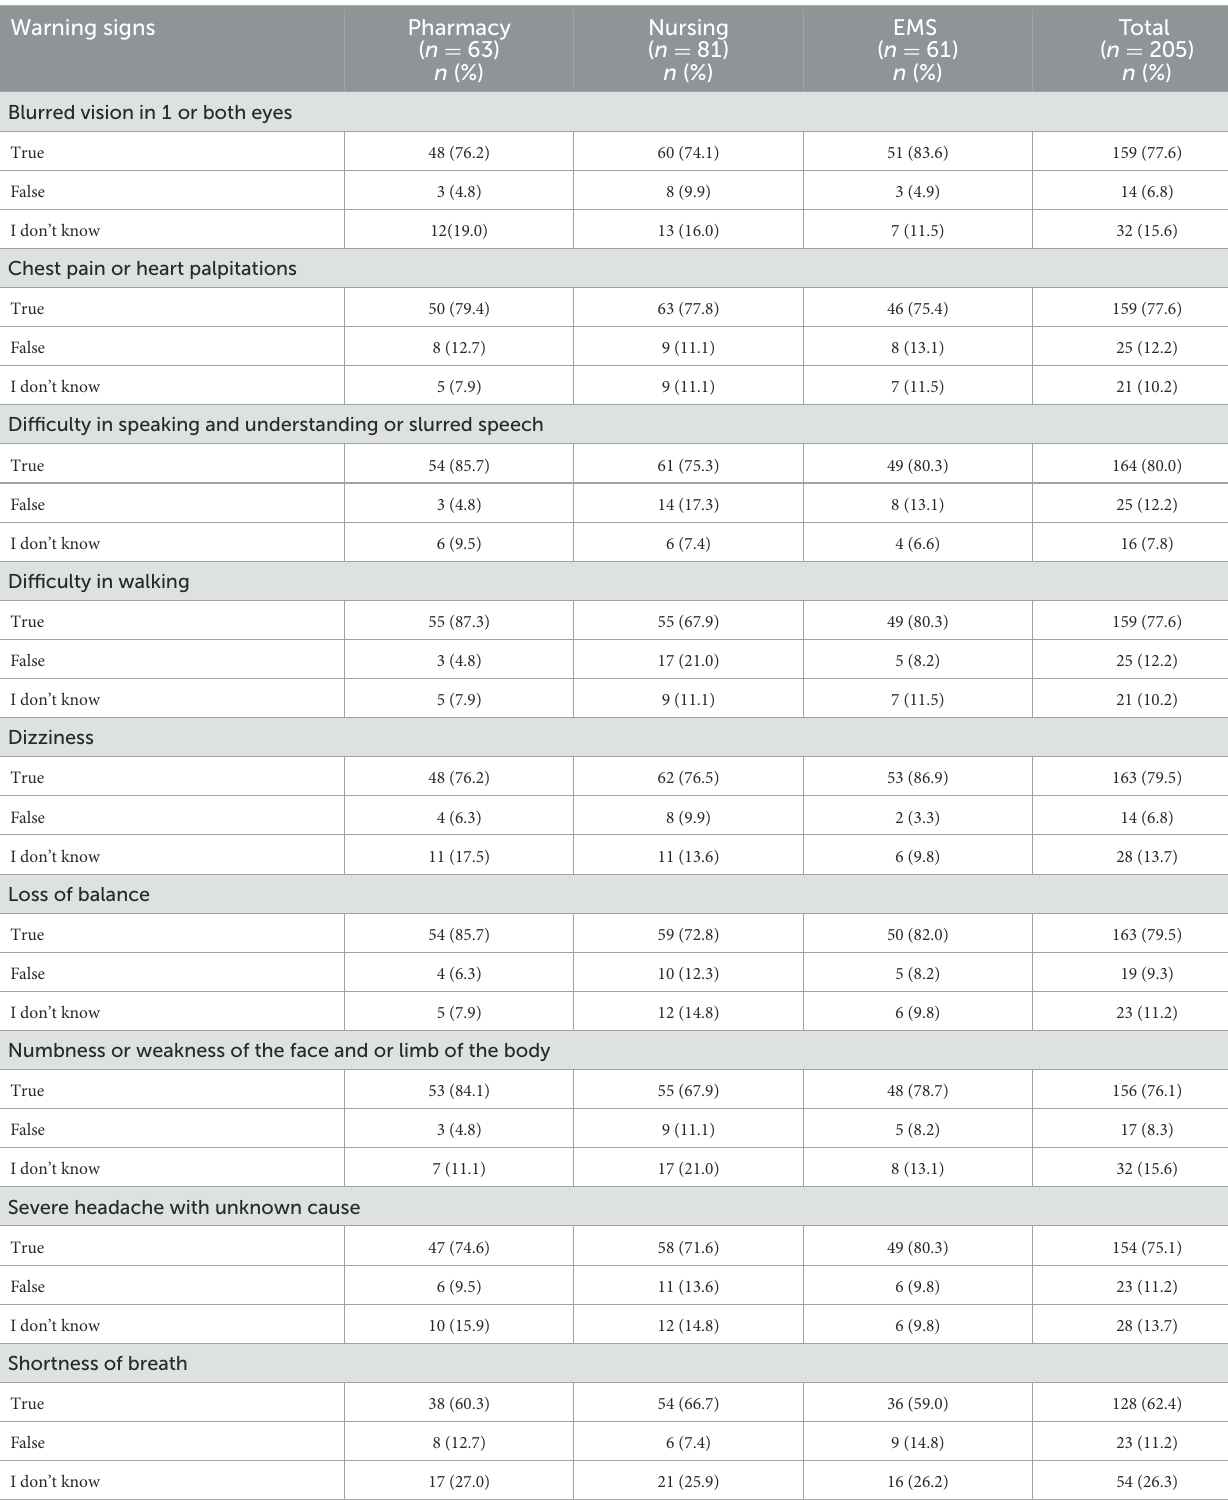
TABLE 3 Participants responses toward warning signs of strokes. Warning